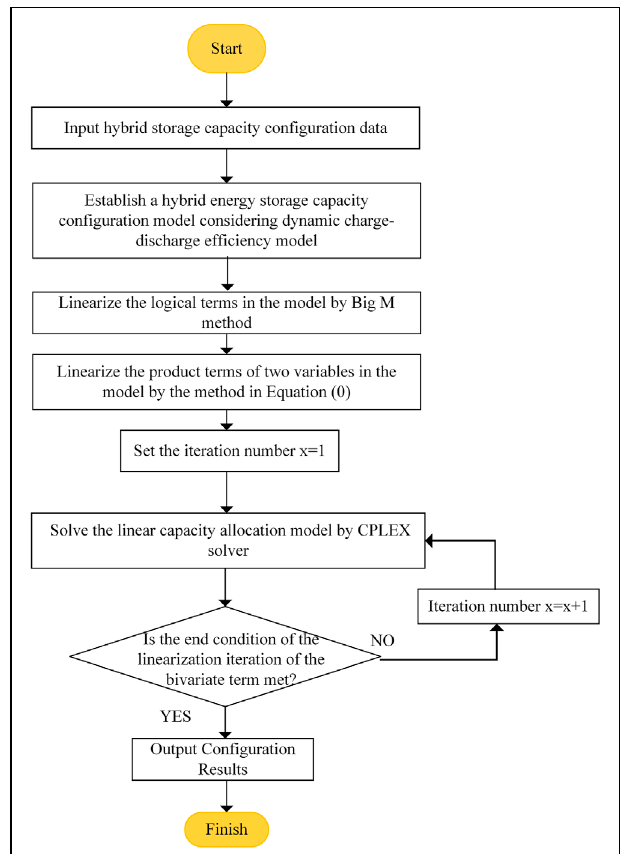
FIGURE 3 | Solution process.